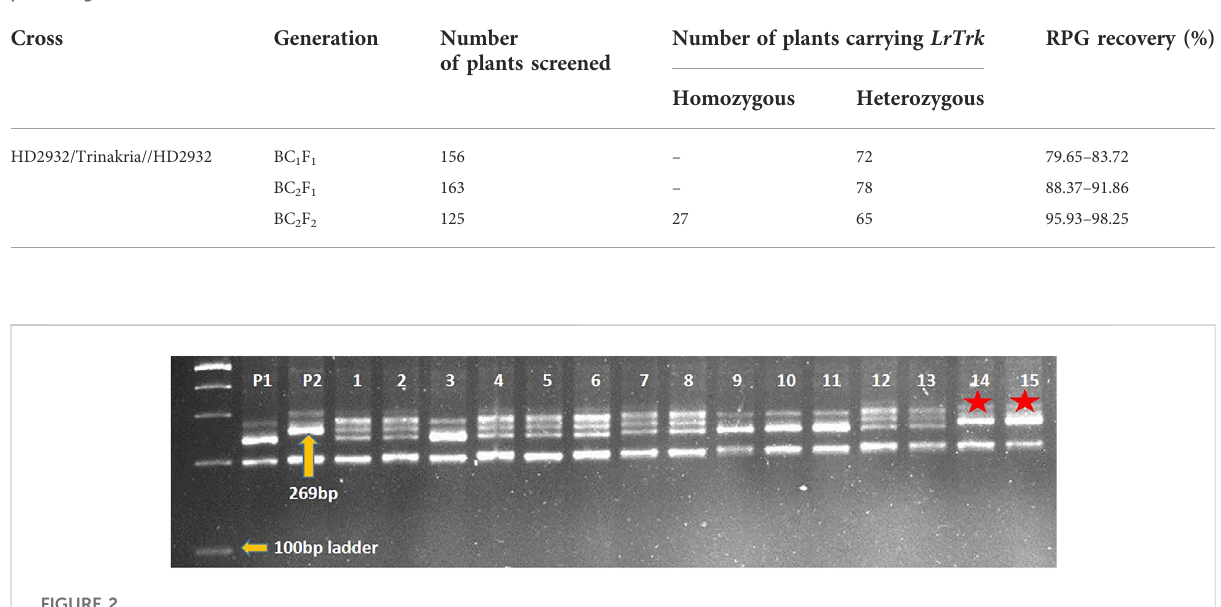
FIGURE 2 Representative gel picture of foreground selection for leaf rust resistance gene LrTrk with linked marker Xgwm234 in BC 2 F 2 generation. P1: HD2932 (RP), P2: Trinakria (DP), 1-15: BC 2 F 2 plants, *plants carrying LrTrk in homozygous state.